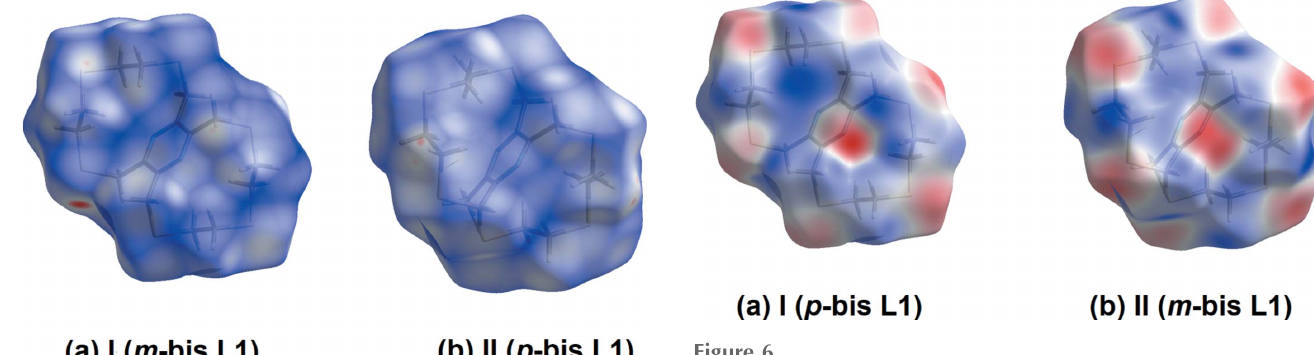
Figure 6 ( a ) The Hirshfeld surface of I , mapped over the calculated electrostatic potential in the range (cid:4) 0.0488 to +0.0302 atomic units, ( b ) the Hirshfeld surface of II , mapped over the calculated electrostatic potential in the range (cid:4) 0.0393 to +0.0283 atomic units. (The red and blue regions norm represent negative and positive electrostatic potentials, respectively.)